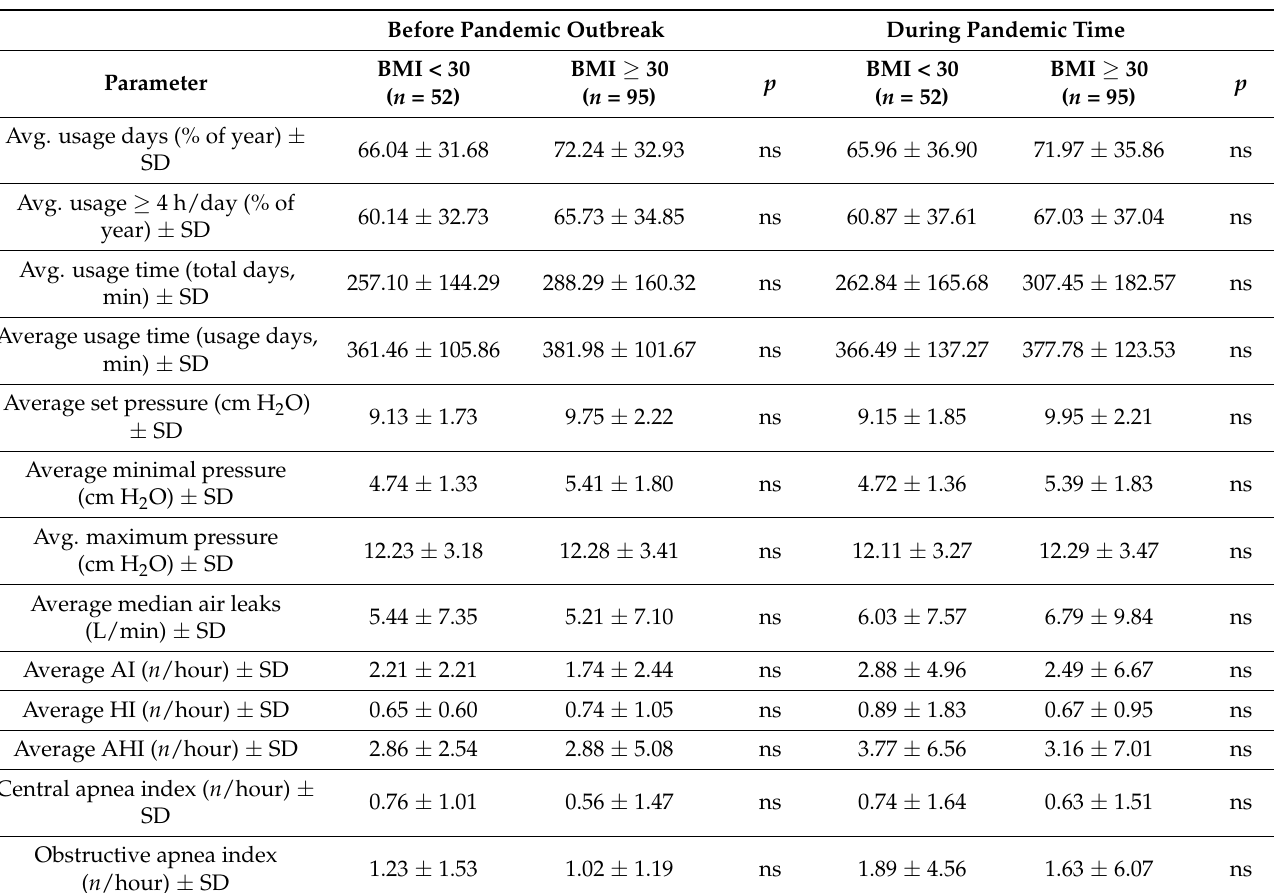
Table 4. CPAP therapy parameters and therapy adherence of study participants before pandemic outbreak and during first year of pandemic time differentiated on the basis of BMI.